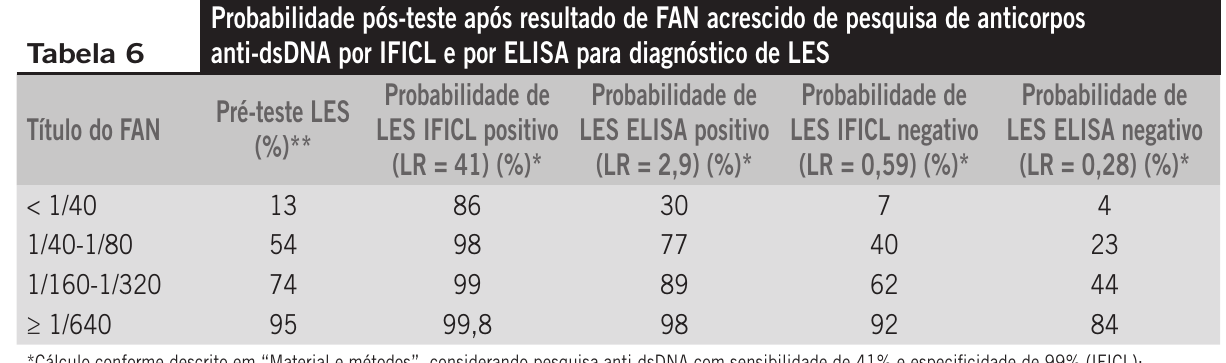
(Figura). Contudo, a sensibilidade do FAN, que foi de